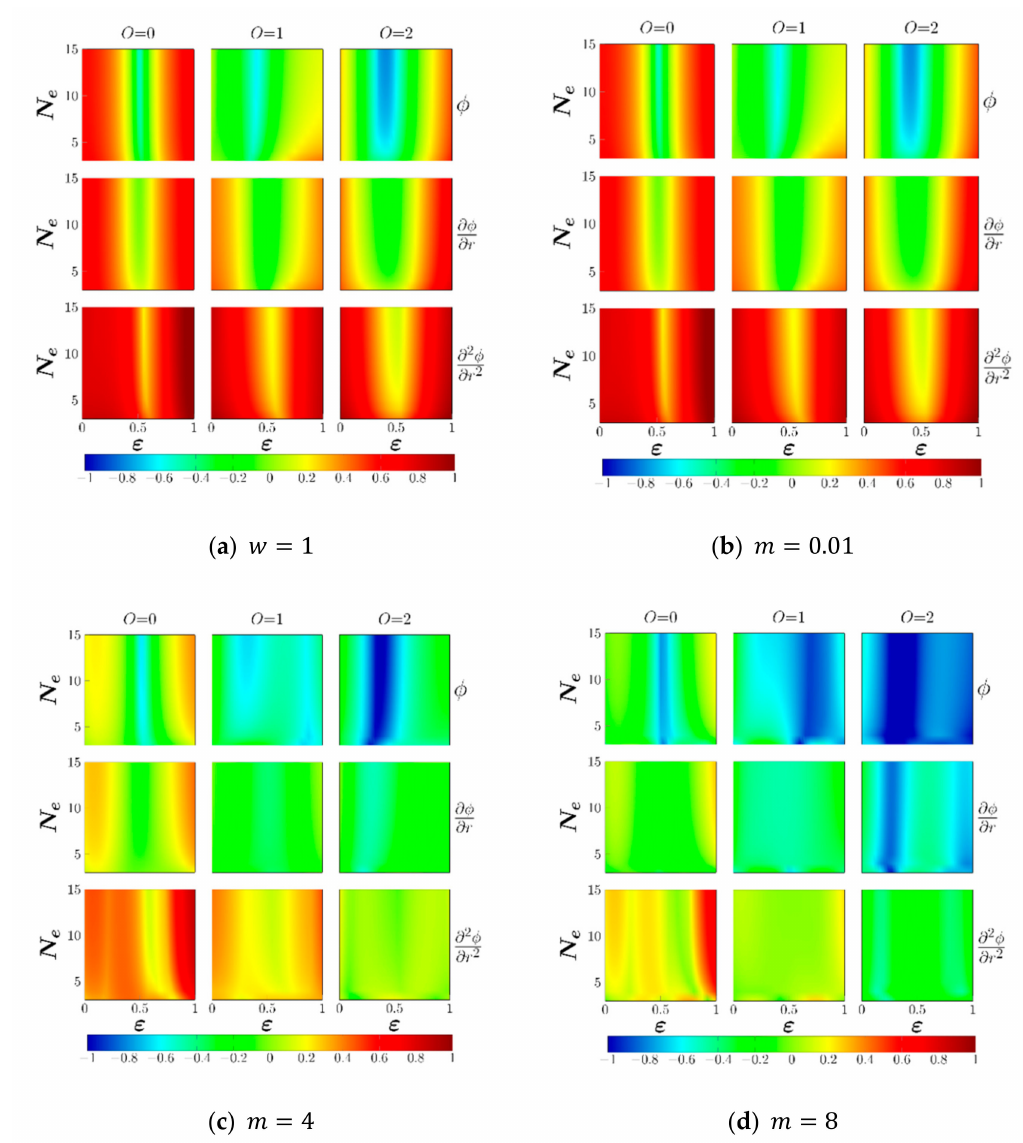
Figure 3. The log10 of the difference between Gaussian RBF and its partition of unity for Taylor series RBF (RBF-TPU) approximation as a function of ε and the number of points of ε k ( N e ) for Gaussian RBF and different truncation orders. The rows are for function, first derivative, and second derivative approximations of RBF, while the columns are for the zeroth ( O = 0), first ( O = 1), and second ( O = 2) orders of